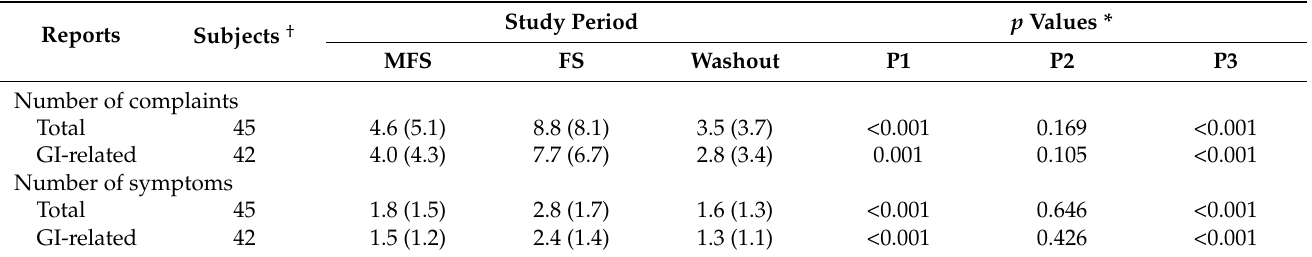
Table 4. Number of complaints and symptoms related to iron consumption.